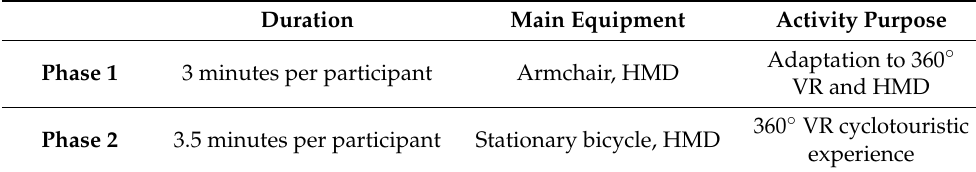
Table 1. Description of VR cyclotourism experience